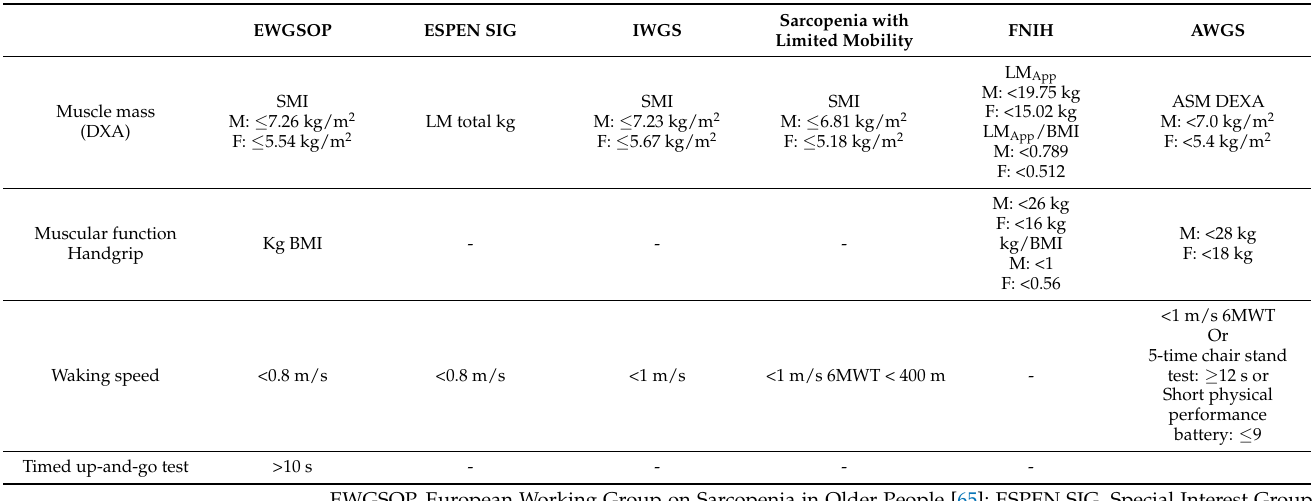
Table 3. Diagnostic criteria for sarcopenia